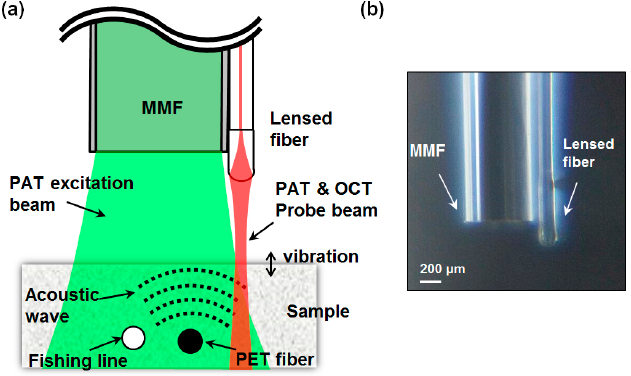
Figure 2. ( a ) Schematic and ( b ) photograph of the all-fiber microsized probe. It is composed of a lensed single-mode fiber (SMF) for optical coherence tomography (OCT) and photoacoustic tomography (PAT) interrogation, and a multimode fiber (MMF) for PA excitation.